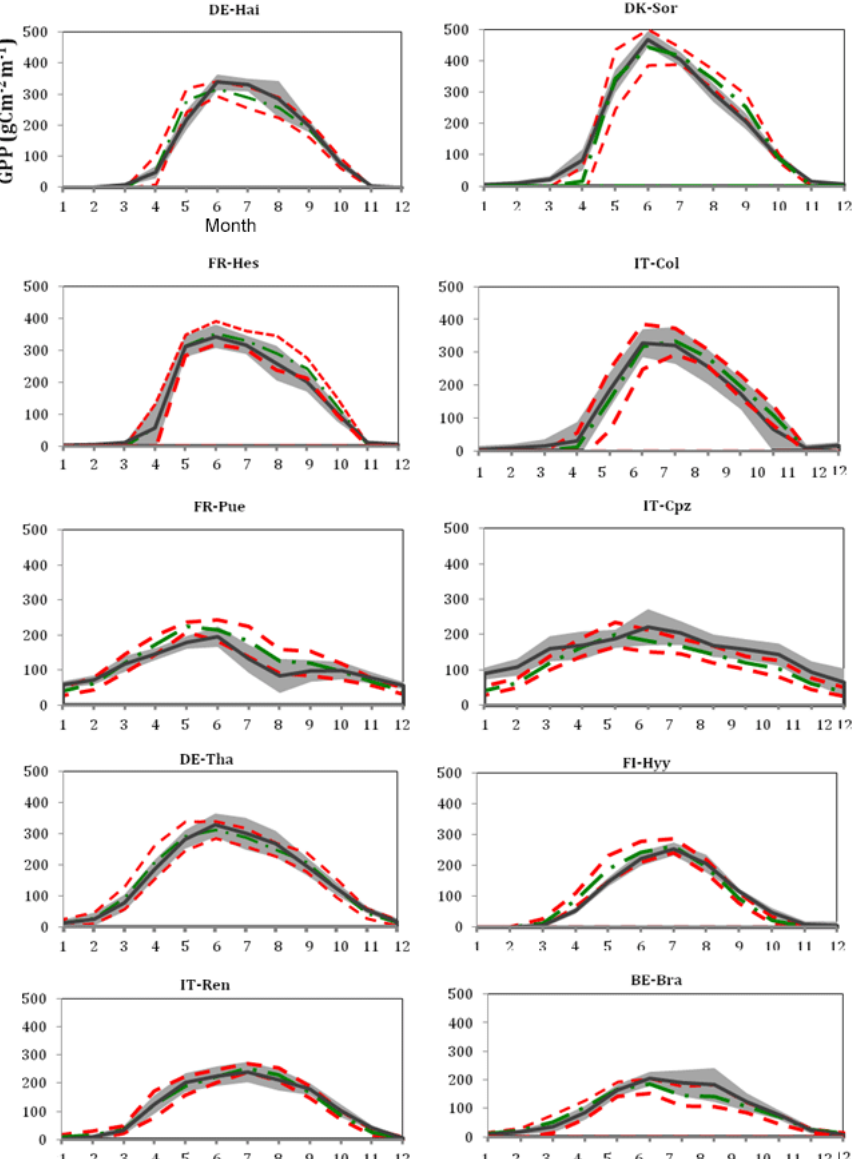
Figure 7. Seasonal (monthly) cycle of GPP across the 10 sites. The grey line and margins of the grey area represent long-term average of monthly GPP EC (gCm − 2 month − 1 ) and its ± 1 standard deviation, respectively. The green and red dashed lines represent the long-term average of monthly GPP MD (gCm − 2 month − 1 ) and its ± 1 standard deviation, respectively. DE-Tha refers to the 1S simulation, IT-Ren